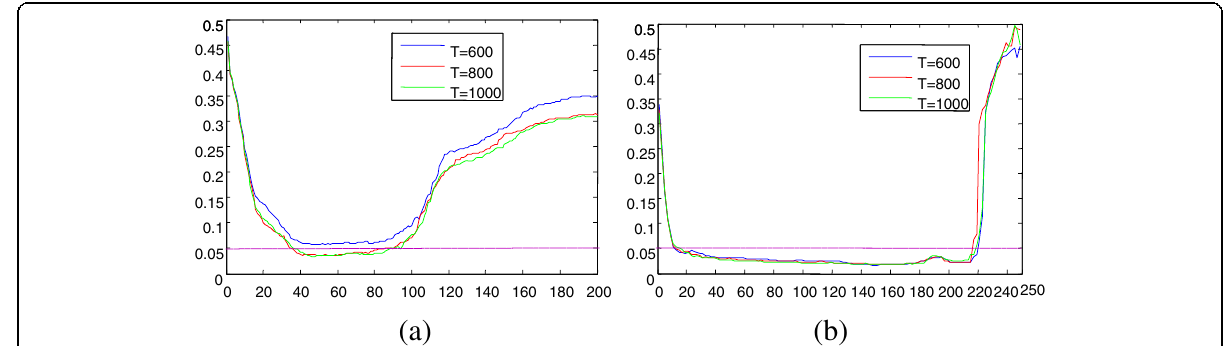
Fig. 15 ME of our method versus T and α for the rice and license-plate images. a The mouse image with the Gaussian noise (0, 0.010). b The license-plate image with the Gaussian noise (0,